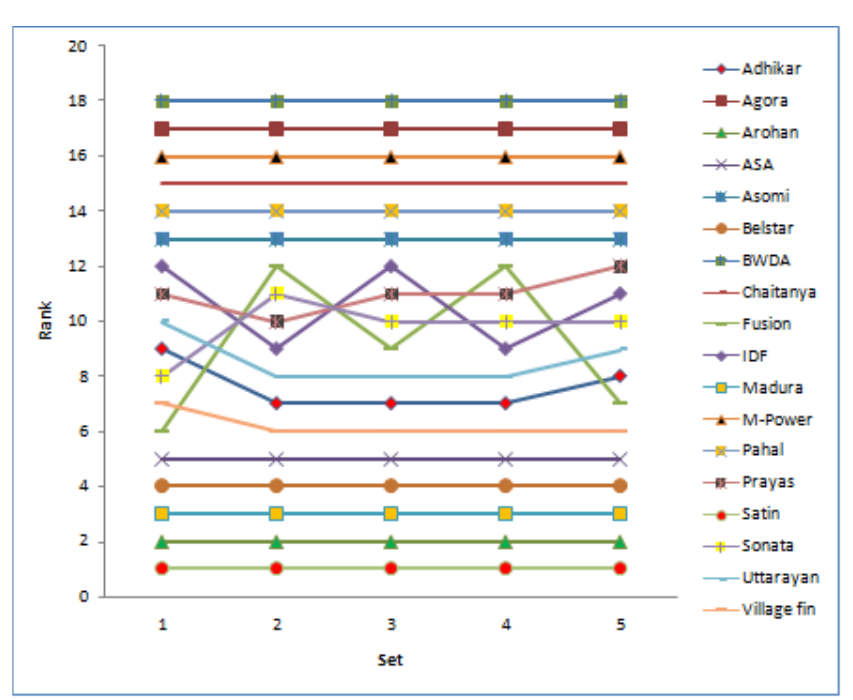
Figure 3. Sensitivity